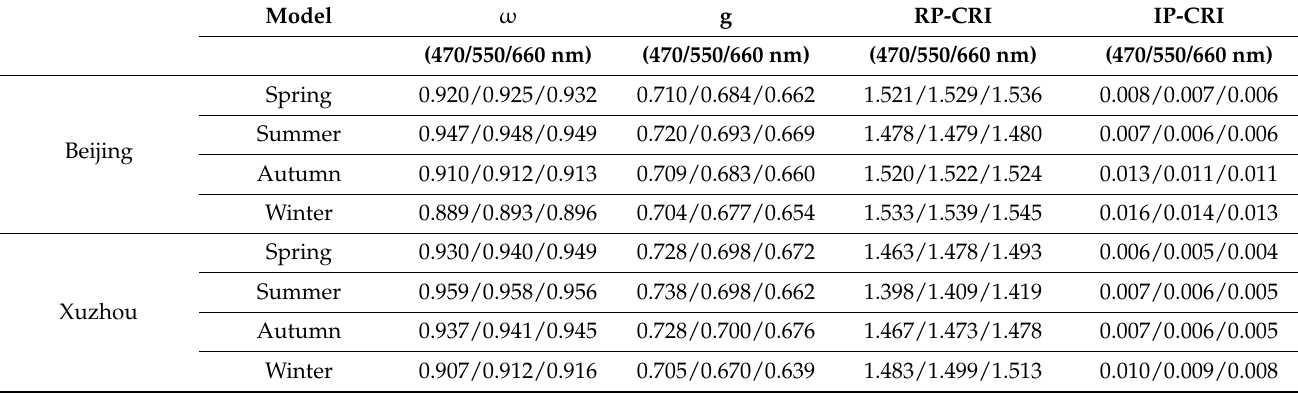
Table 2. Optical properties for customized seasonal aerosol models used in the AOD